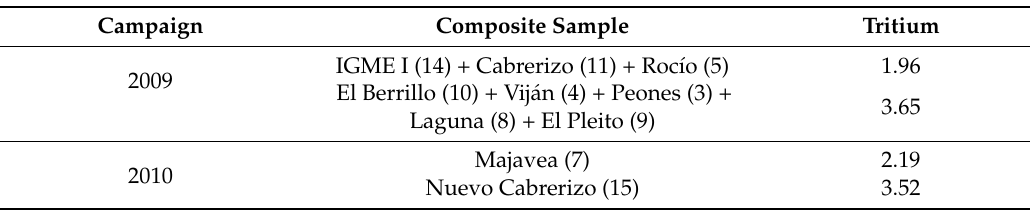
Table 4. Results of the measurement of tritium activity in groundwater in the May 2009 (composite samples) and March 2010 field